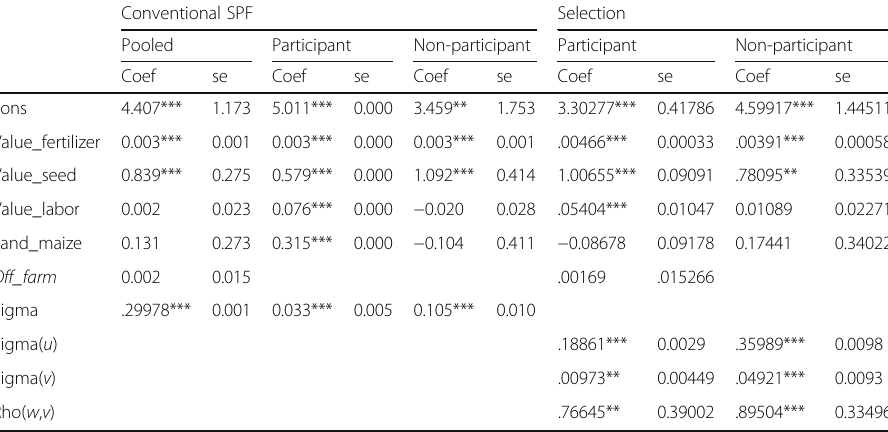
Table 5 Conventional and selection SPF based on matched